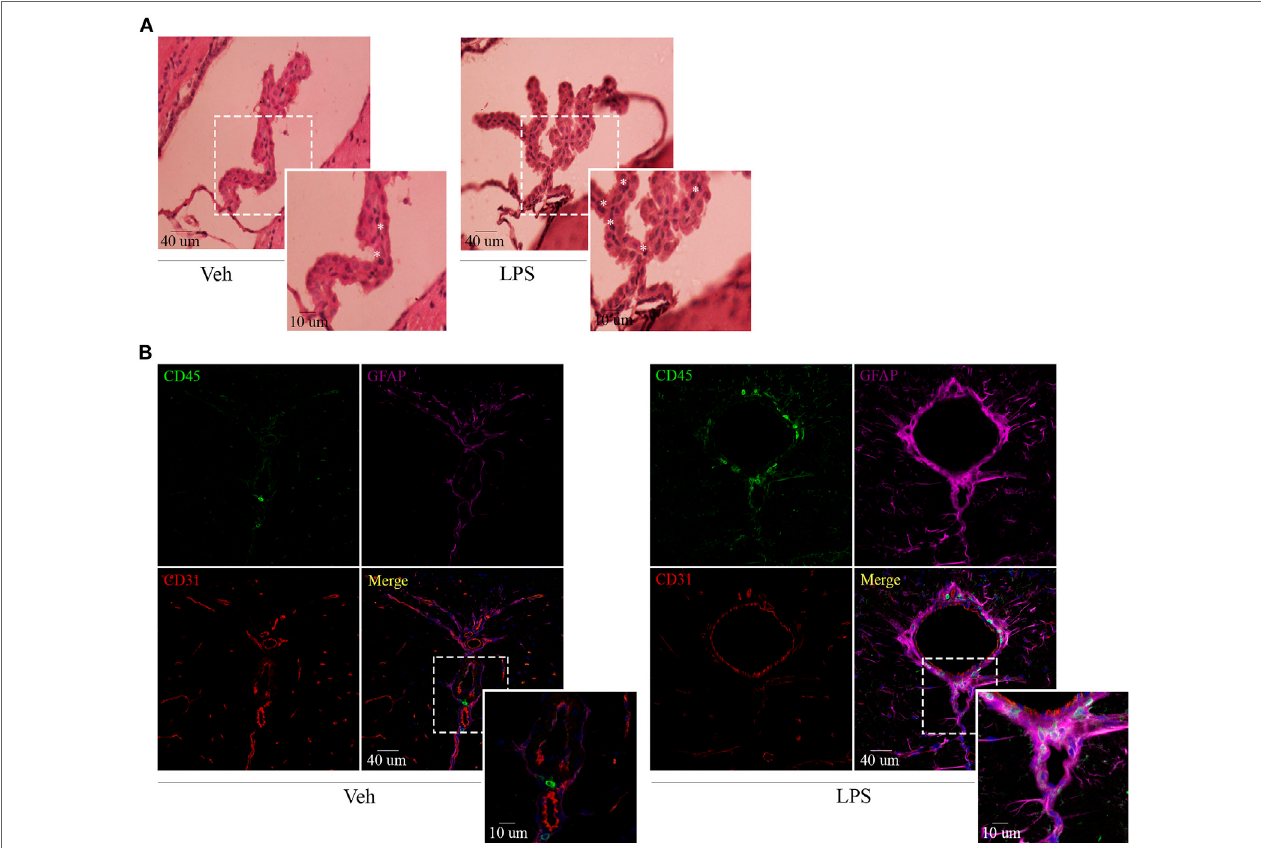
FigUre 3 | Lipopolysaccharide (LPS) challenge induces glial activation and recruitment of leukocytes to CVOs. Mice were treated i.p. with either vehicle or 40 µg of LPS (1,6 mg/kg) for four consecutive days to induce neuroinflammation. Twelve hours post the last injection, mice were euthanized and brains collected. (a) H&E micrographs of the choroid plexus. Scale bars, 40 µm (main panels), 13 µm (inset). The asterisks denote recruited leukocytes. Results are representative of at least two independent experiments ( n = 3–4 animals per group). (B) Confocal micrographs of CVOs depicting cluster of differentiation (CD45)-low microglial cells and high recruited leukocytes (upper-left, green), glial fibrillary acidic protein-positive astrocytes (upper-right, false-colored magenta), and cluster of differentiation (CD31)- positive endothelial cells (lower-left, red). DAPI counterstain (blue) shows nucleus. Scale bars, 40 µm (main panels), 13 µm (inset). Results are representative of at least three independent experiments ( n = 3–4 animals per